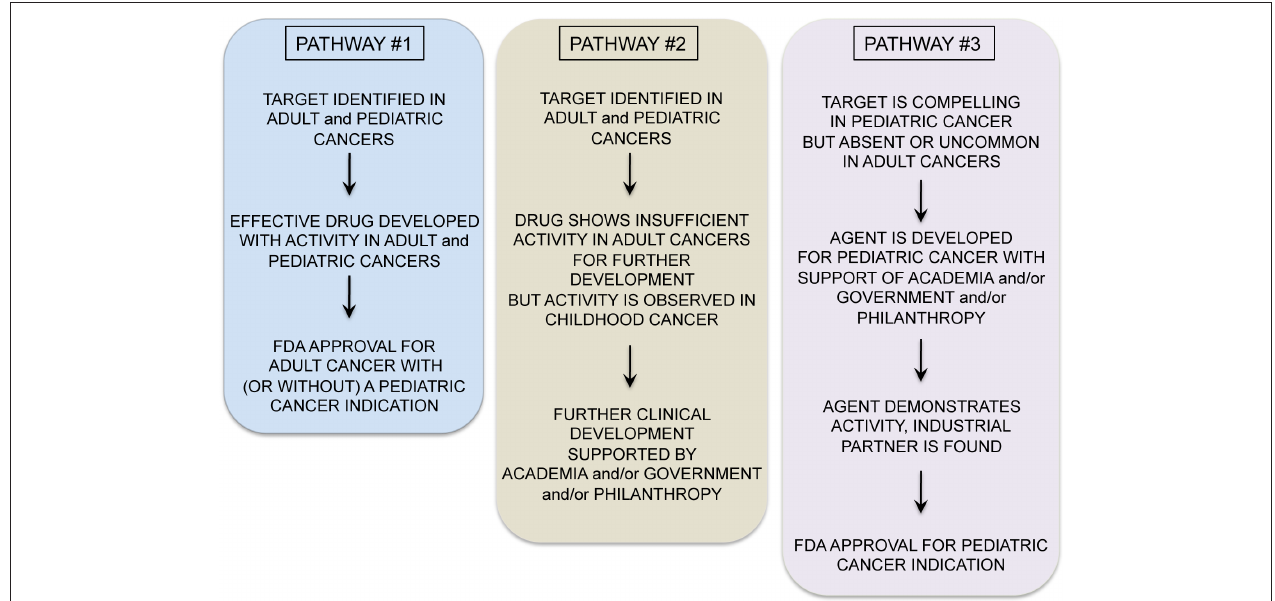
Figure 1 | Pathways for targeted cancer drug development in pediatric